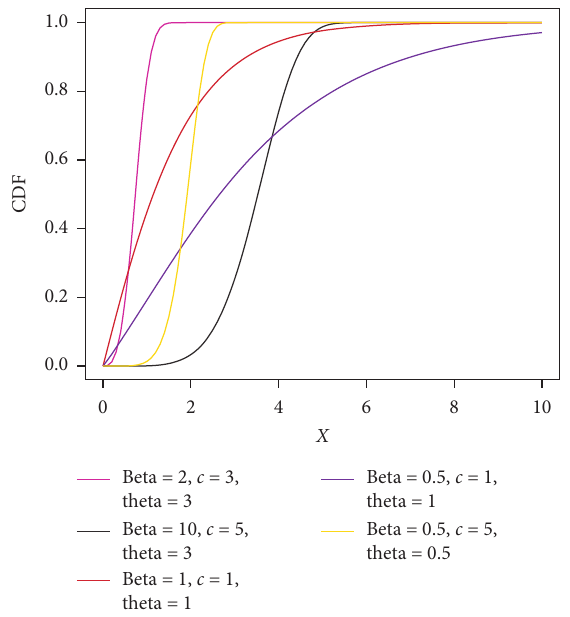
Figure 3: Survival curves for generalized Weibull–Lindley (GWL) distribution for different parameter